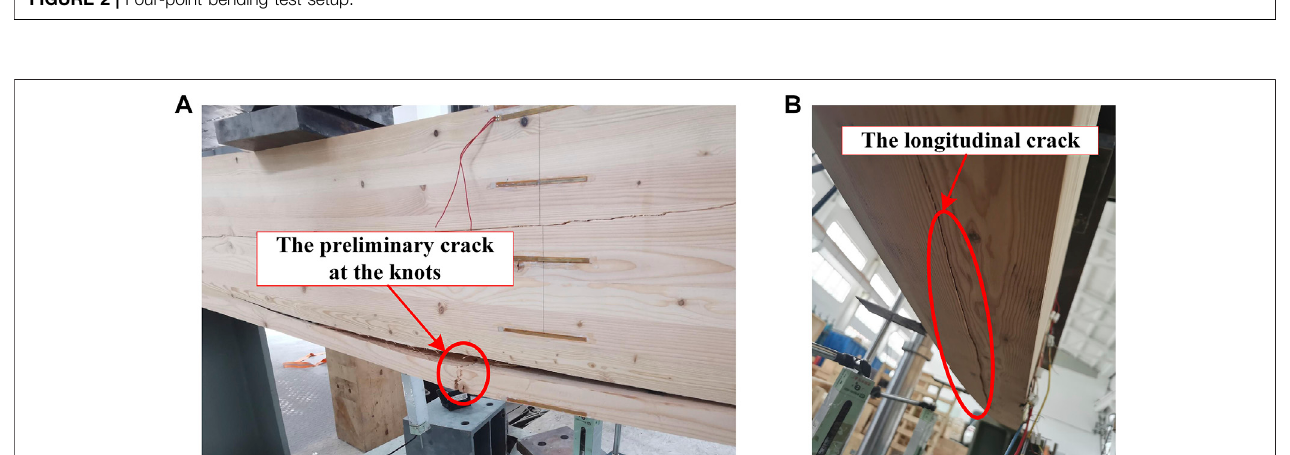
FIGURE 3 | Bending failure of unreinforced beams: (A) crack at knots and (B) longitudinal crack.